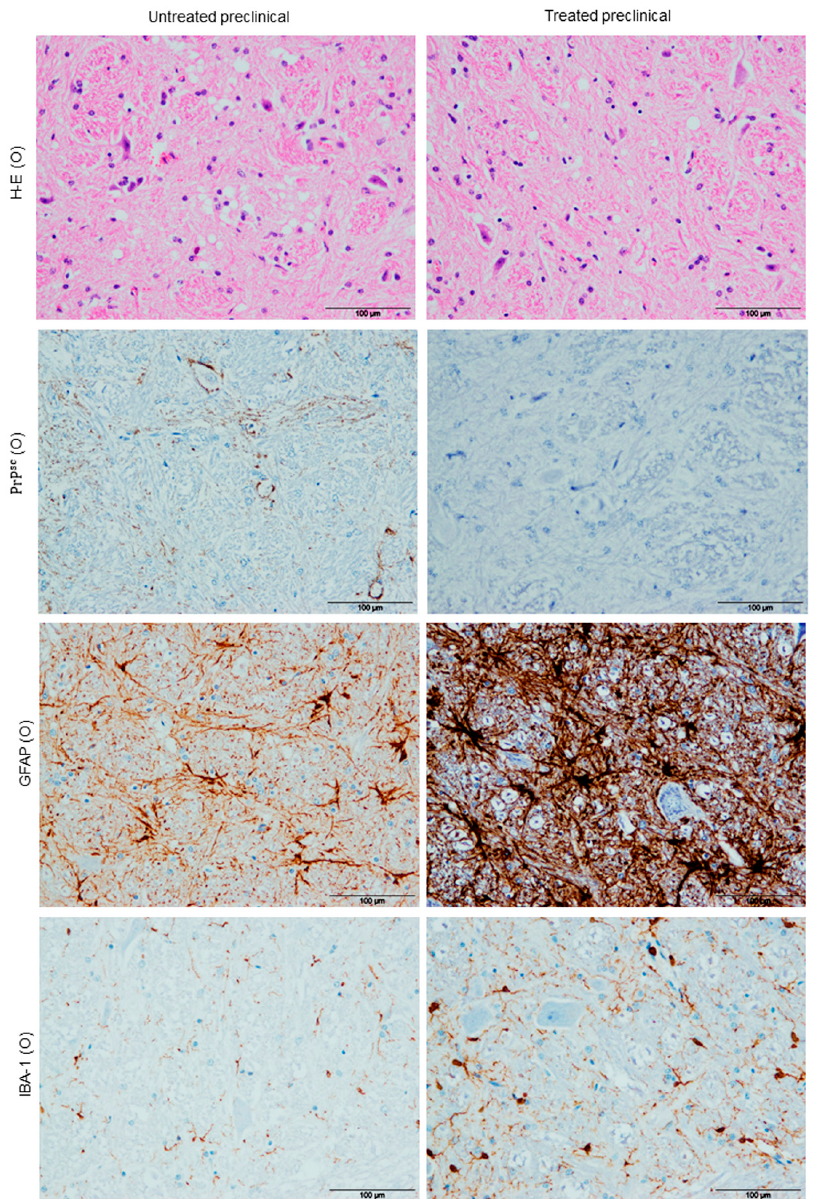
Figure 1. Neuropathological findings. Dexamethasone (DEX) treatment in preclinical sheep was associated with a reduction in vacuolation and pathological prion protein (PrP sc ) deposits (as illustrated in obex O), while it was associated with a huge increase in astrogliosis and microgliosis in this same brain area. Scale bars: 100 µ